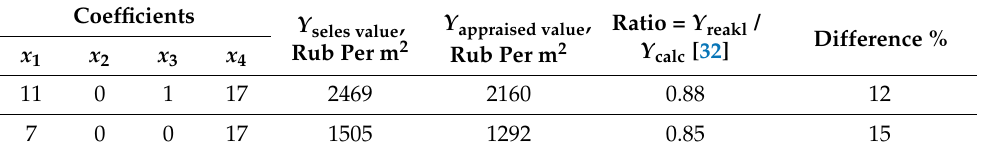
Table 9. The model checking on a control